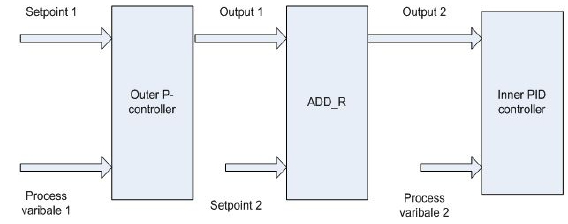
Figure 6. Setup of cascade controller in PLC.